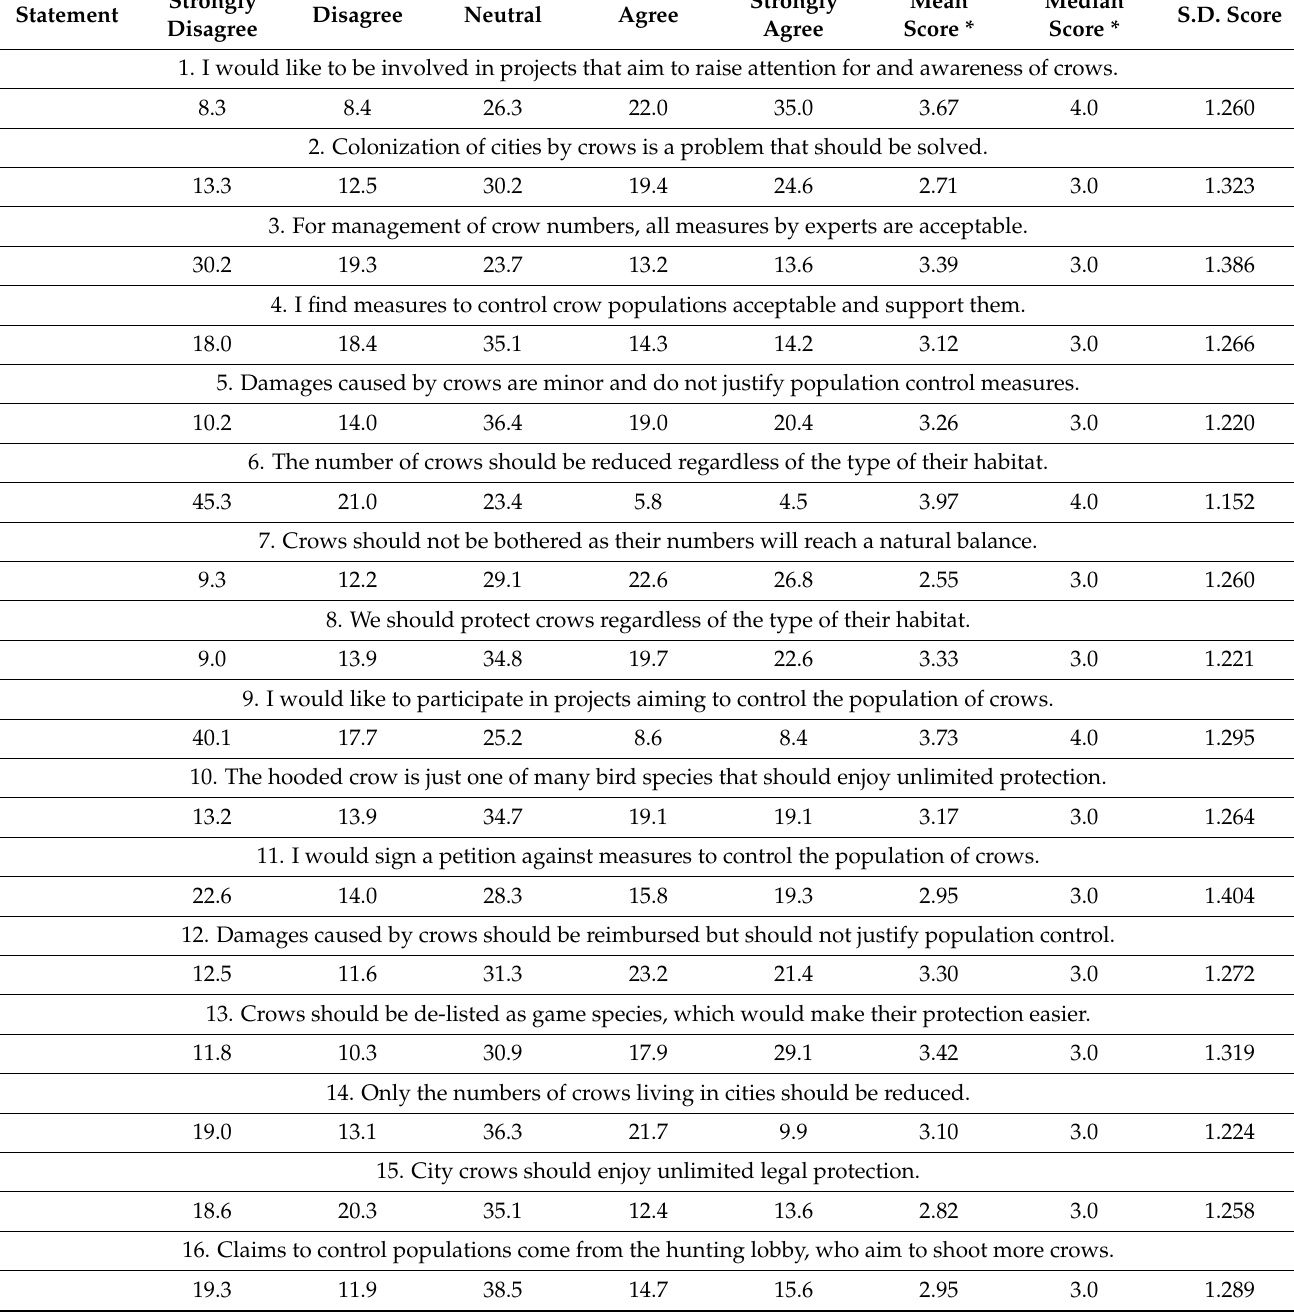
Table 2. Percentages, mean, median and S.D. of responses to statements on coexistence with hooded crows. Statements highlighted in grey are negatively coded and interpreted. * In cases of highlighted statements, reverse values (mean and median) are